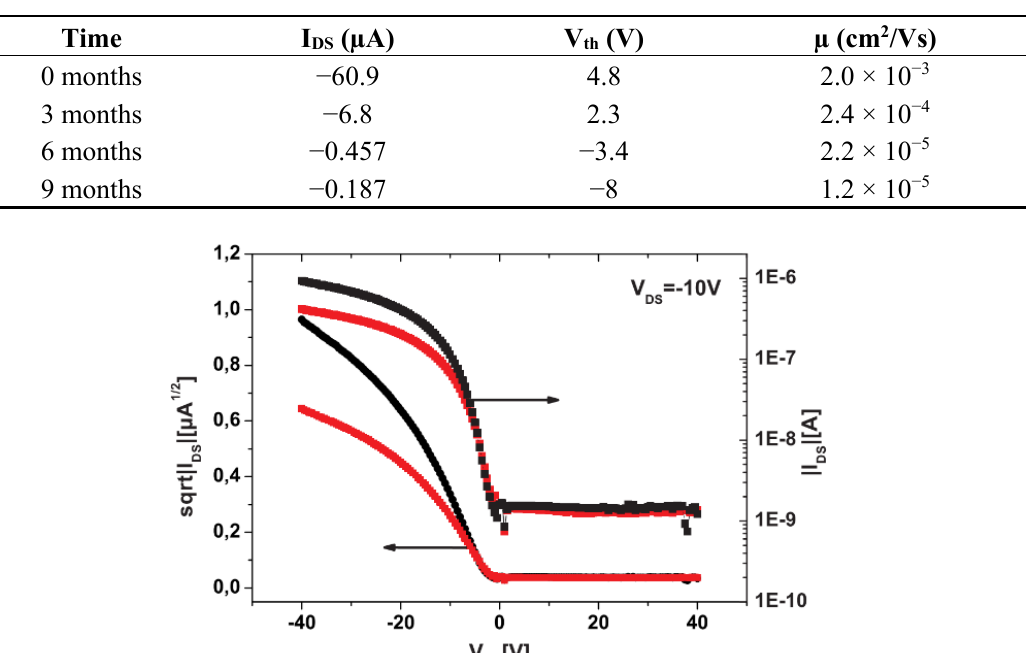
Table 1. Behavior of the electrical parameter of an inverted coplanar pentacene OFET-device after 9 months of investigation. Reprinted from [55], with permission from Cambridge University Press.